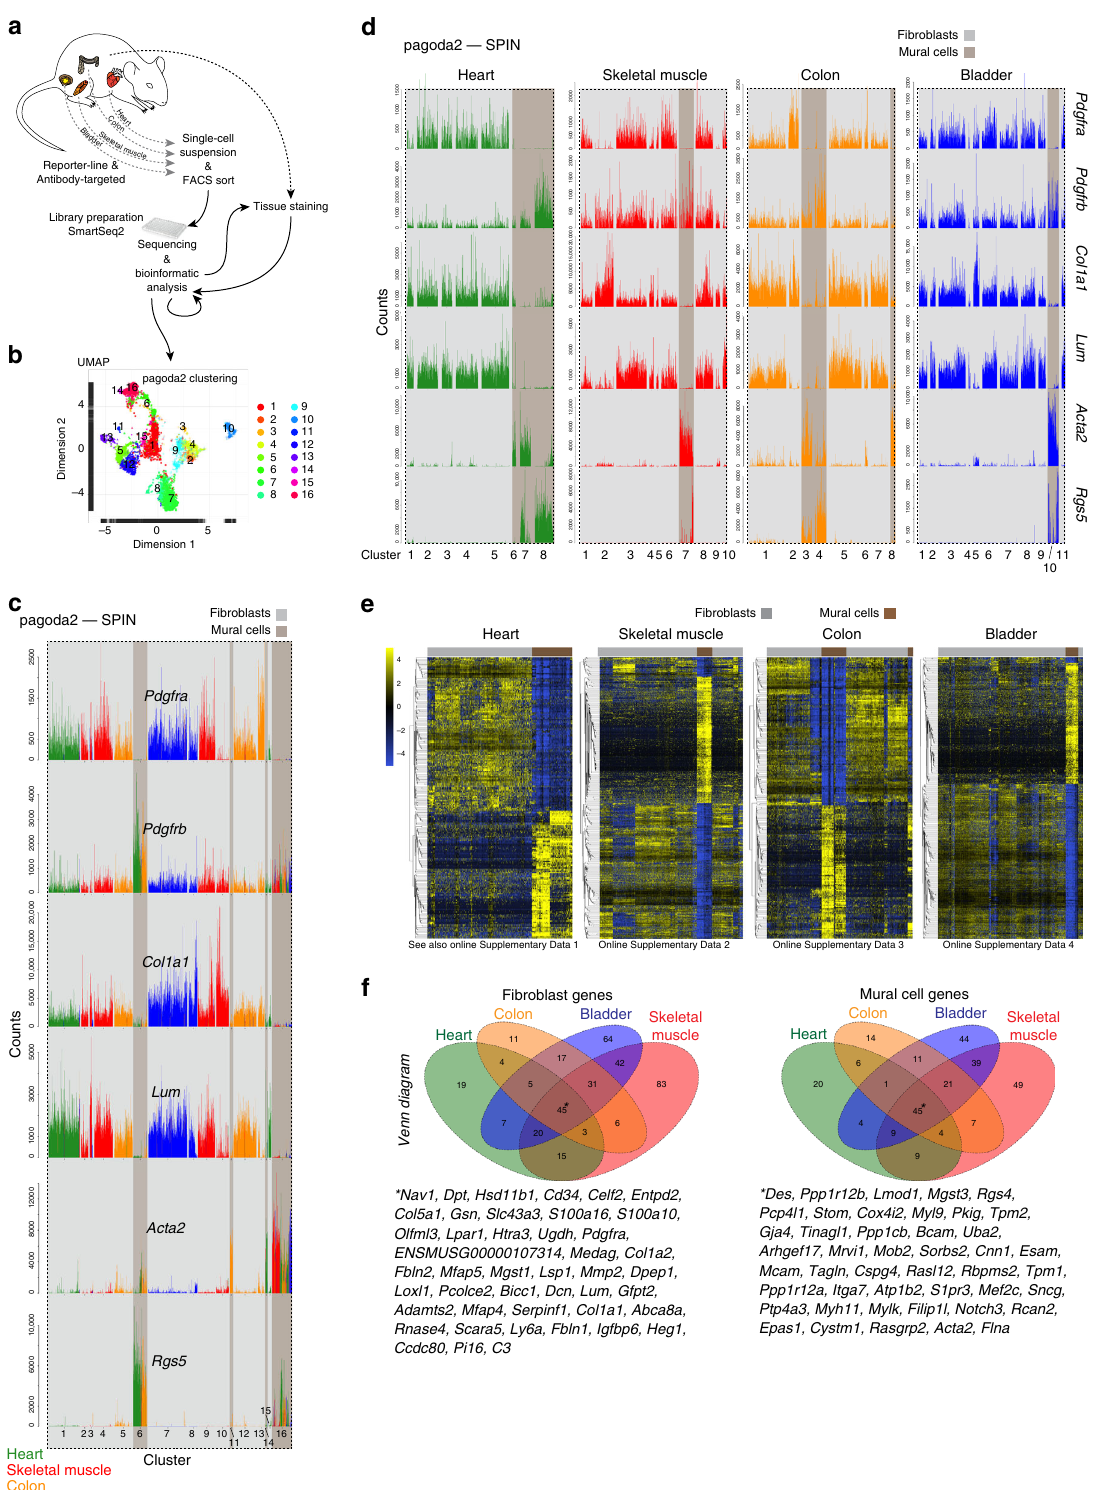
Fig. 1 Outline and cell archetype identi fi cation. a Study outline. b Pagoda2 clustering of the complete dataset (16 clusters) superimposed onto a UMAP dimensional reduction visualization. c Bar plots showing the expression of canonical fi broblast and mural cell markers in individual cells (bars) of the 16 pagoda2 clusters, the cell order in each cluster determined by SPIN. d Same data as in c but with pagoda2 clusters assigned and cells SPIN-ranged in each organ separately (see Supplementary Fig. 2a for corresponding UMAPs). e Expression heat maps (blue, low; yellow, high) showing the most differentially expressed genes between fi broblasts and mural cells in each respective organ dataset (for zoomable images, see Online Supplementary Datas 1 – 4). f Venn diagrams of differential expressed genes within the respective organ. Middle/asterisk: list of markers common for the four organs (see also Supplementary Table